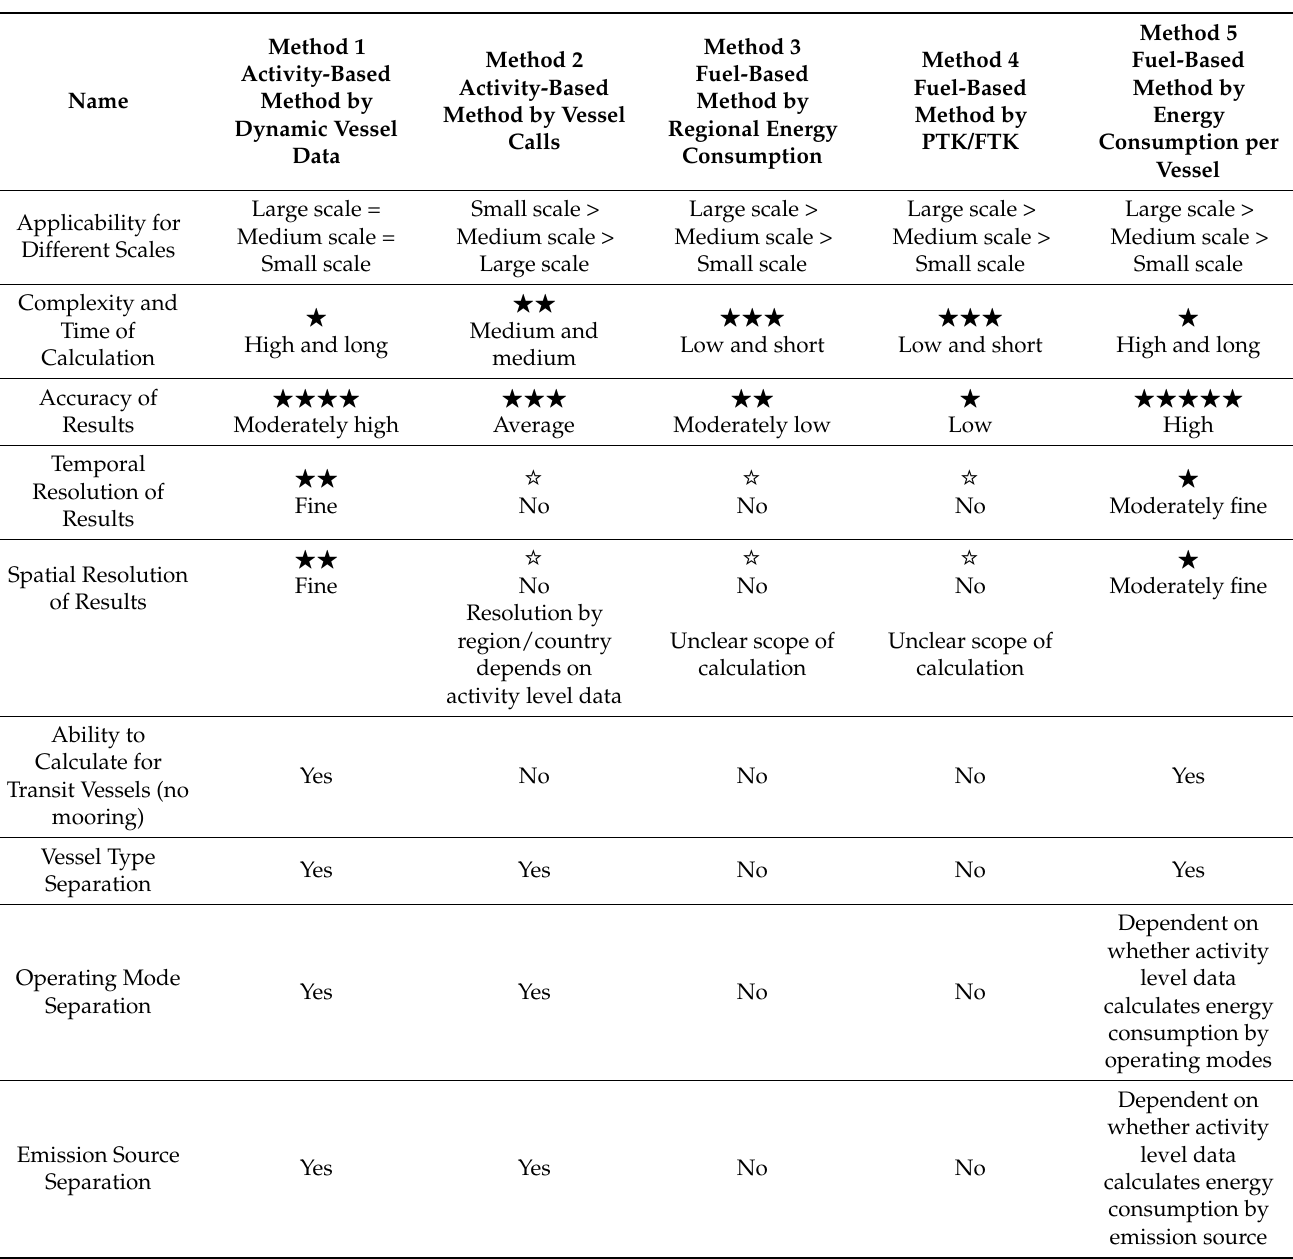
Table 2. Comparison of technical characteristics and applicability of main